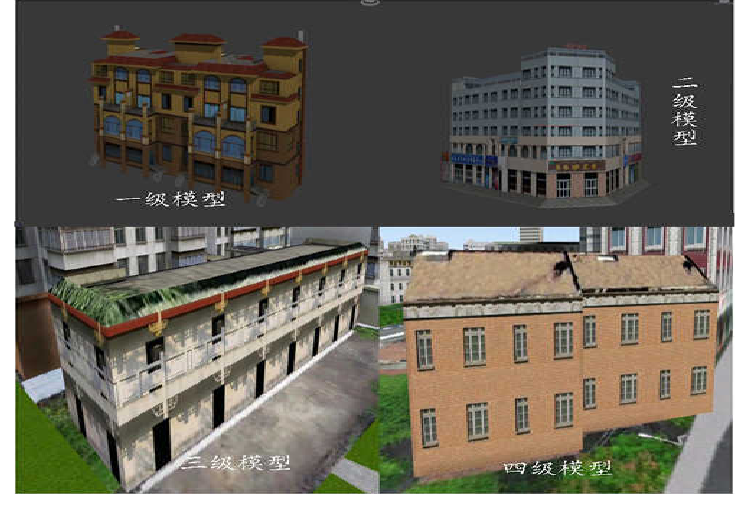
Fig. 3 Comparison of models at all levels Tab.2 Standards for modeling technical